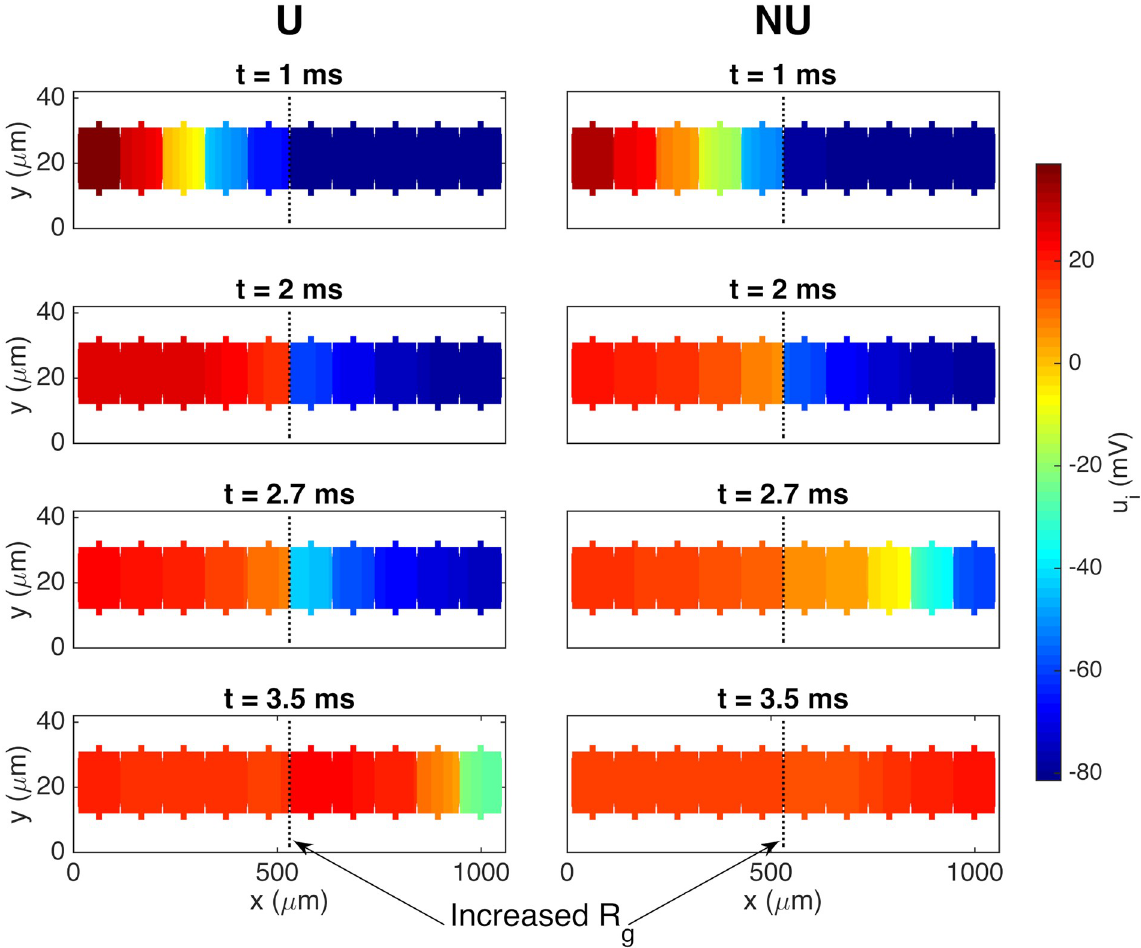
Fig 11. Illustration of increased gap junction delay for a uniform distribution of sodium channels compared to a non-uniform distribution. The figure shows the intracellular potential in the plane at the center of the domain in the z -direction at four points in time for the case with a uniform (U) and a non-uniform (NU) distribution of sodium channels. The default gap junction resistance is increased by a factor of 10 from 0.0045 k O cm 2 to 0.045 k O cm 2 between the fifth and sixth cells. The remaining parameter values used in the simulations are given in Table 1, except that the time step is set to Δ t = 0.01